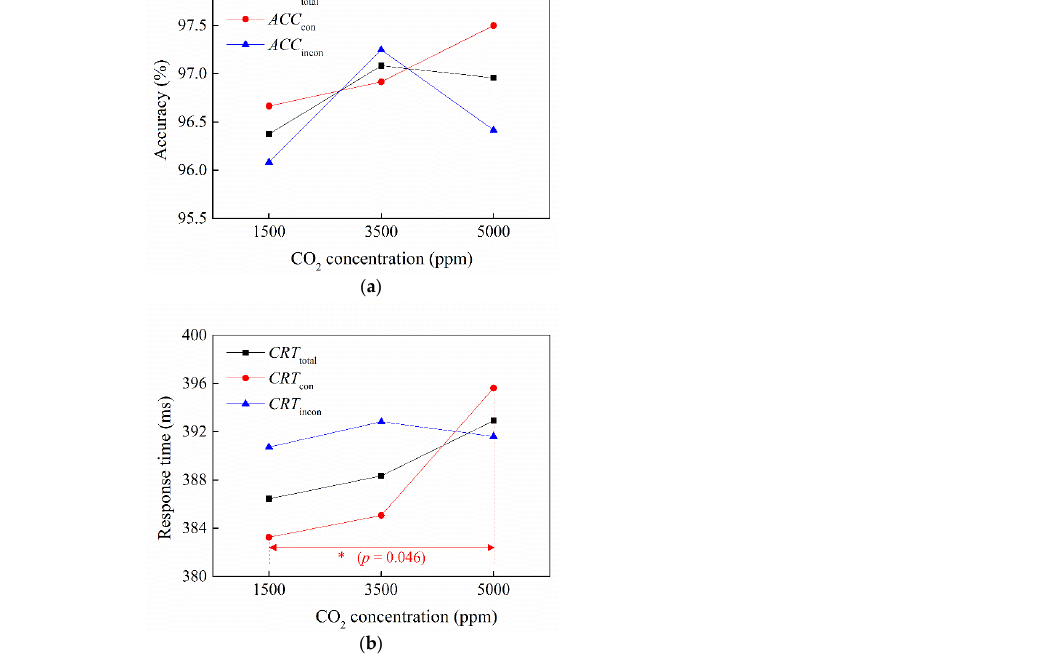
Figure 7. Performance metrics of the Stroop test under different CO 2 conditions; * ( p < 0.05). ( a ) Accuracy. ( b ) Response time.